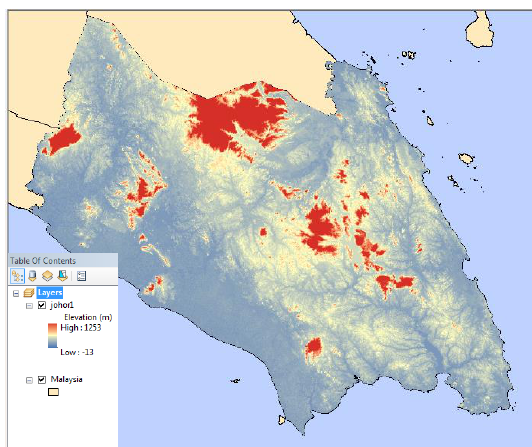
Figure 4. Continues type of raster (e.g.